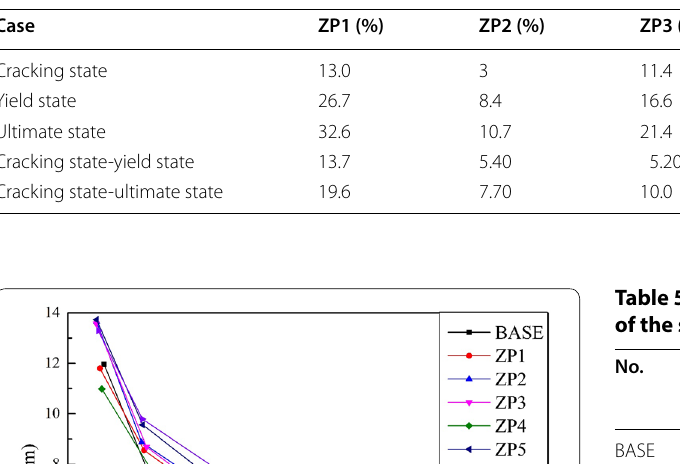
Table 4 Strain loss conditions of tested PC specimens.